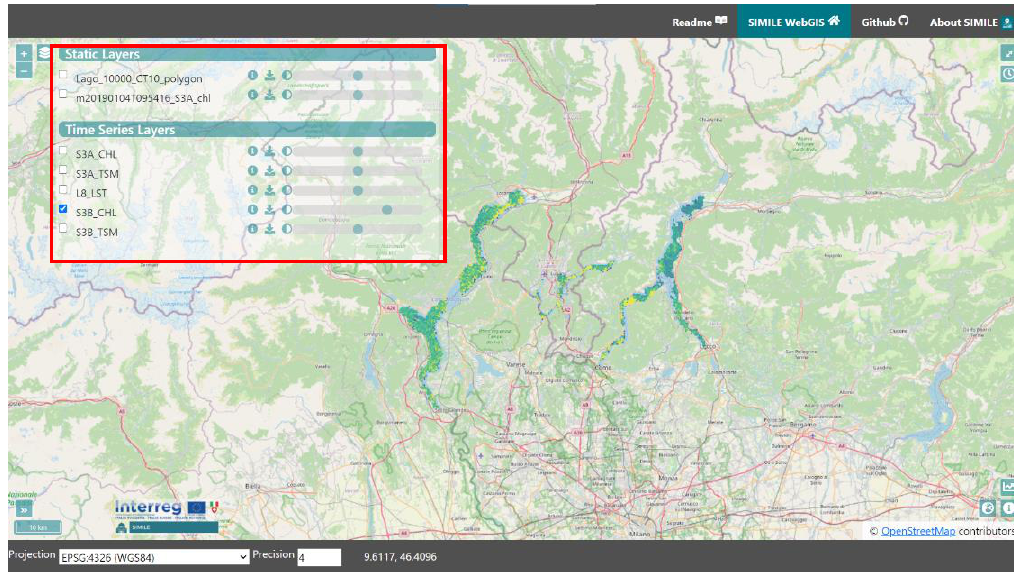
Figure 3. WebGIS user interface, table of contents view